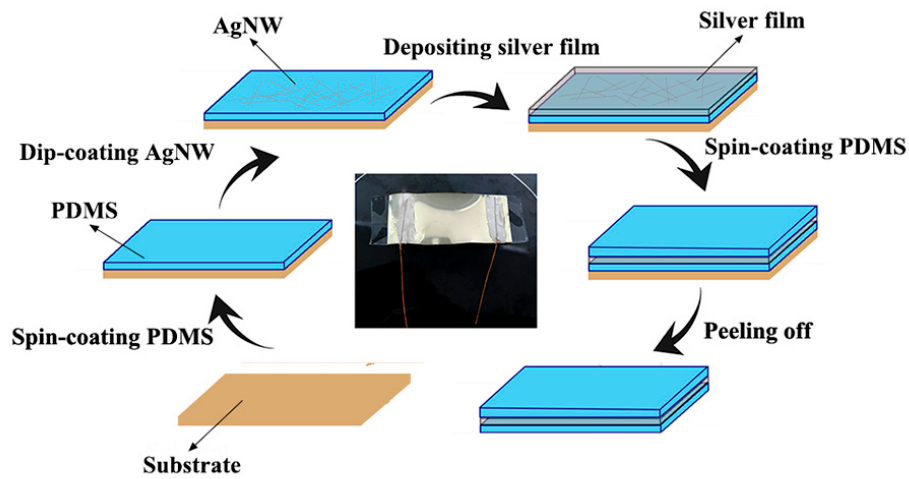
Figure 1. Schematic illustration of the fabrication of the strain sensor.